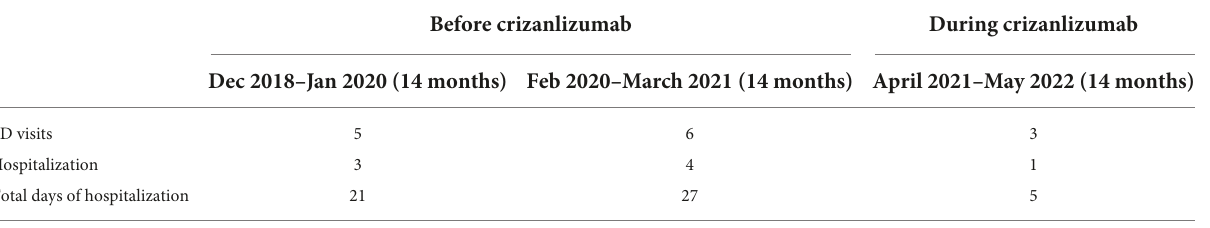
TABLE 2 Frequency of emergency department visits (ED), hospitalization, and total days of hospitalization before and during crizanlizumab